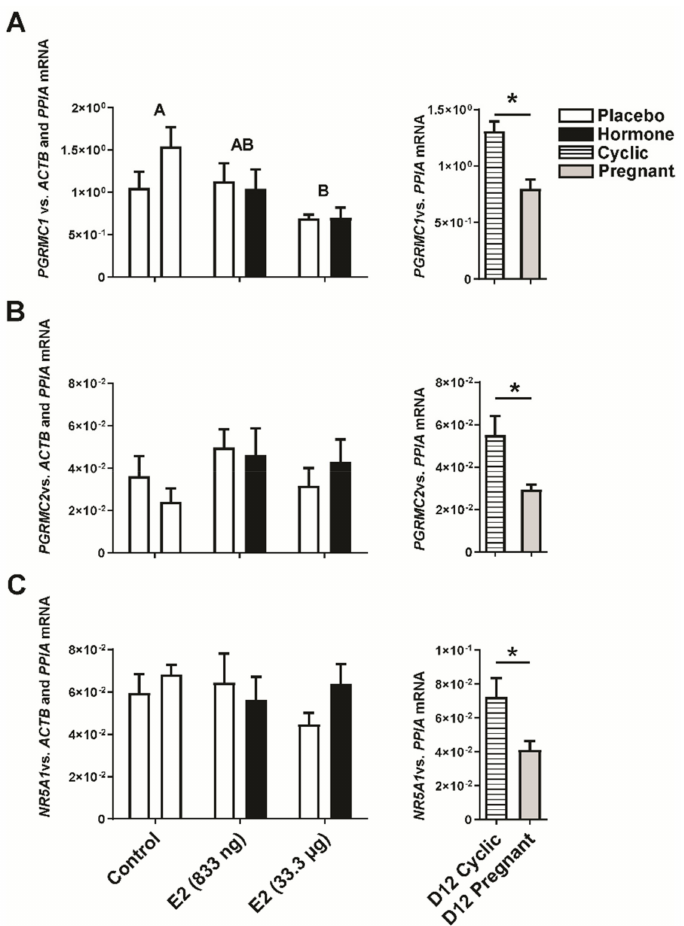
Figure 5. Expression of progesterone receptor membrane component 1 ( PGRMC1 ; ( A )), and 2 ( PGRMC2 ; ( B )), and nuclear receptor subfamily 5 group A member 1 ( NR5A1 ; ( C )) genes in the corpora lutea collected from E2- and placebo-treated gilts. Control—gilts receiving placebo infusions into both uterine horns. E2—gilts receiving infusions of either placebo into one randomly selected horn or E2 (833 ng or 33.3 µ g/infusion) into contralateral horn. As referential groups, gilts on day 12 of the estrous cycle (D12 Cyclic) and pregnancy (D12 Pregnant) were included. Values of target gene expression were normalized against geometrical mean of ACTB and PPIA expression values (luteal samples from in vivo model) or PPIA expression values (luteal samples from day 12 pregnant/cyclic pigs). Main effect of treatment was detected on luteal expression of PGRMC1 mRNA (E2-treated groups vs. the control group; p < 0.05). There was no significant effect of the site of hormone administration (i.e., the placebo-treated uterine horn vs. the hormone-treated uterine horn within the same animal) on luteal expression of analyzed genes. Data are expressed as the mean ± SEM. Different letters indicate statistically significant differences between control- and hormone-treated gilts ( p < 0.05). Asterisk indicates statistical differences between gilts on day 12 of the estrous cycle and pregnancy ( p <